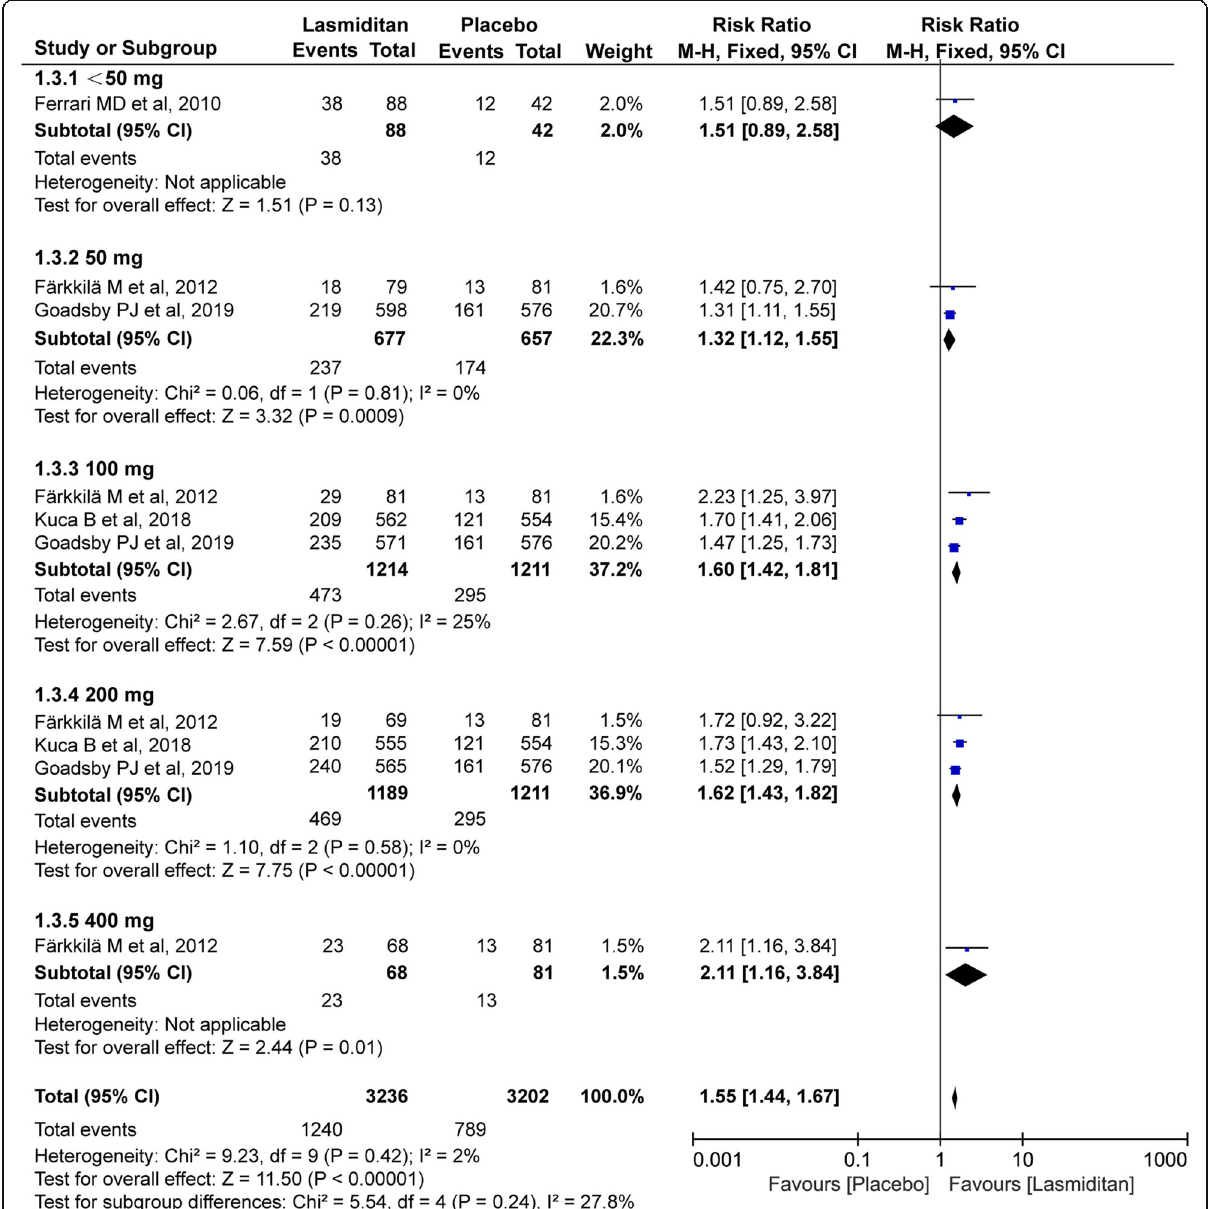
Fig. 5 Meta-analysis of the global impression (very much/much better) at 2 h after therapy with lasmiditan compared with placebo. The diamond indicates the estimated relative risk with 95% confidence interval for the pooled patients. M-H, Mantel-Haenszel; CI, confidence